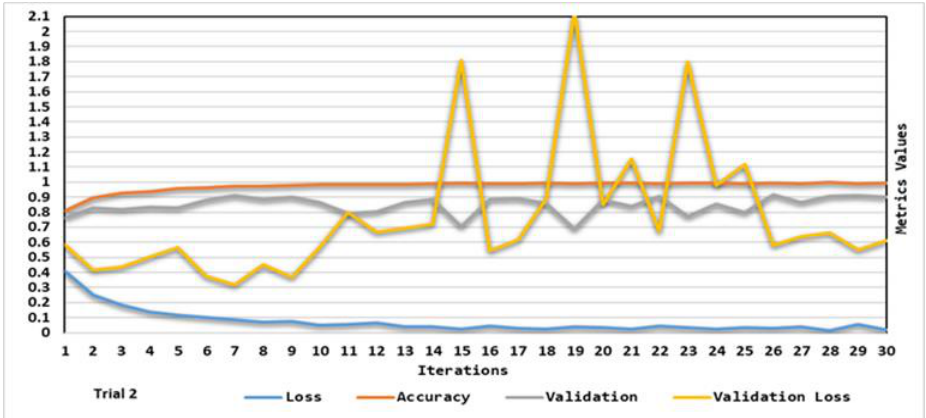
Fig. 6. Using VGG16 model in trial